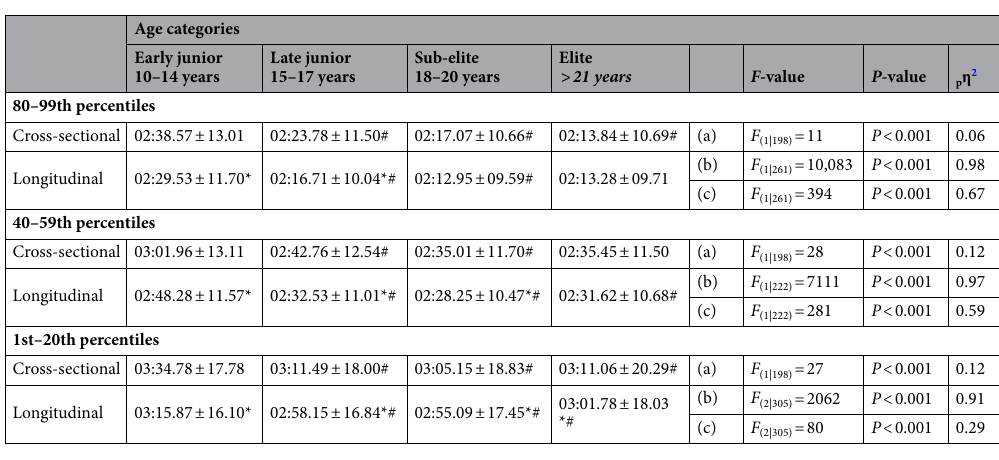
Table 2. Comparison of percentiles based on cross-sectional vs. longitudinal analysis of female swimmers. Analysis of variance (ANOVA) with repeated measure and one between subject factor was used to compare upper (80–99th), medium (40–59th), and lower percentiles (01–20th) based on mean [mm:ss.00] ± standard deviation [ss.00] across the 200 m events of all swimming strokes. (a) Main effect: type of analysis (cross- sectional vs. longitudinal). (b) Main effect: age category (early junior–late junior–sub-elite–elite). (c) Interaction effect: type of analysis x age group. Post-hoc comparison. *Significant difference to cross-sectional analysis. # Significant difference to previous age